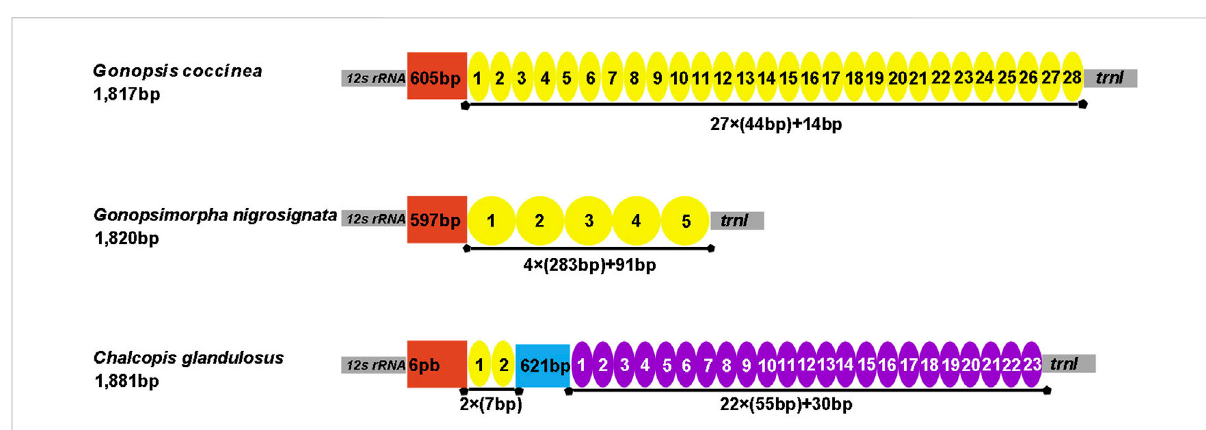
FIGURE 7 Organization of the control region in the three mitochondrial genomes. The location and copy number of tandem repeats are shown by a colored oval with repeat length. Non-repeat regions are shown by the colored box with sequence size